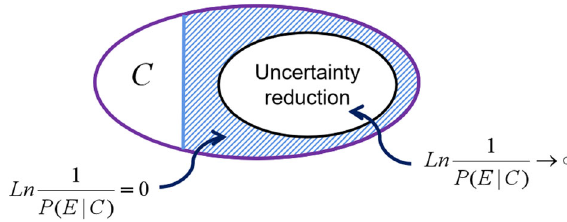
Fig. 1 Feature-matching value. It supports the composition beyond the common source.